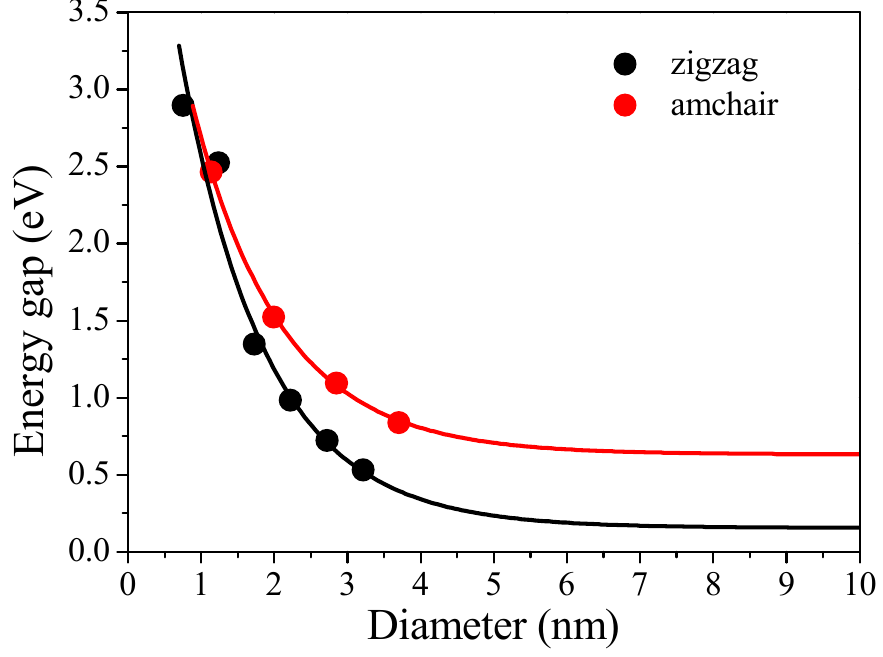
Figure 6. Illustration of the calculated size-dependent electronic gap of the armchair- and zigzag- edged GQDs.